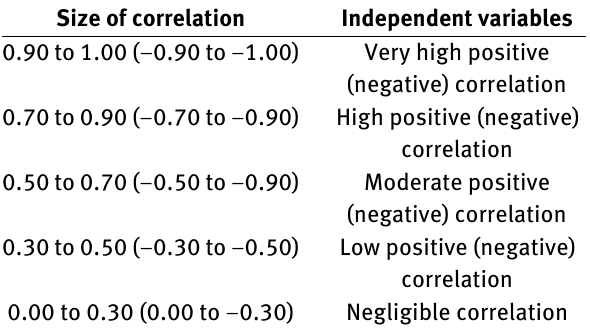
Table 1: Rule of a thumb for interpreting the size of a